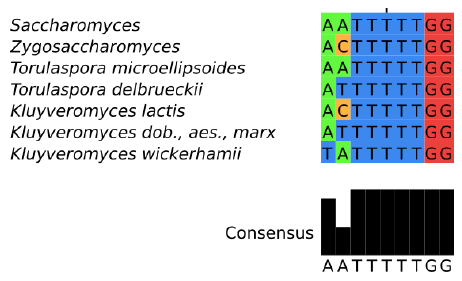
Figure 3. Alignment of the core SM-binding site motif: The common pattern of most Saccharomycetaceae ( top ); and species-specific variants ( bottom